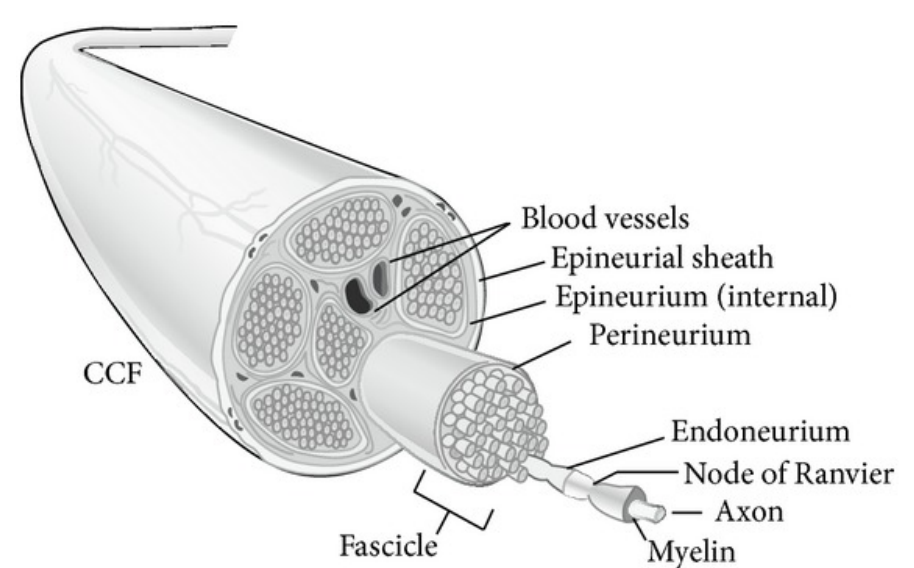
Figure 1. Peripheral nerve (axon) anatomy. Reproduced with permission from ref. [2] .